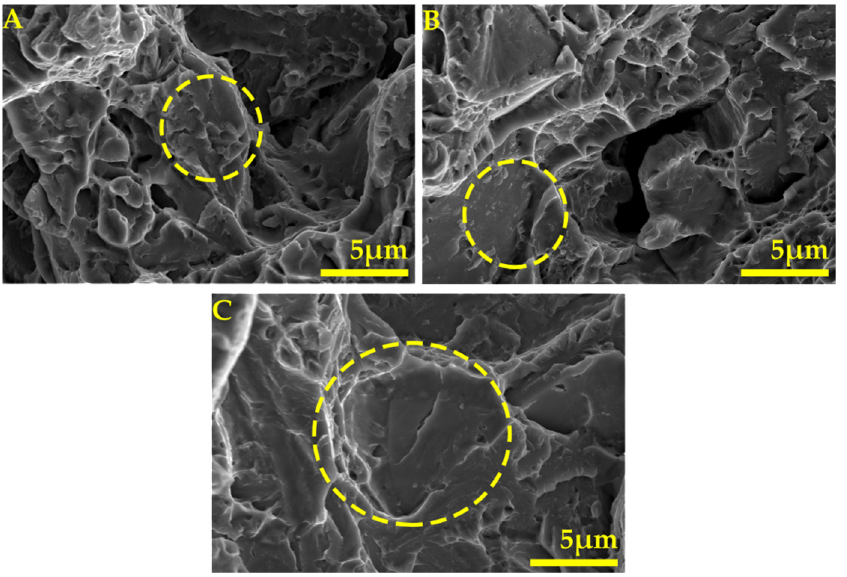
Figure 11. Fracture surfaces of the heat-treated steel samples after ( A ) MULTISTEP1, ( B ) MULTISTEP2, ( C ) MULTISTEP3.